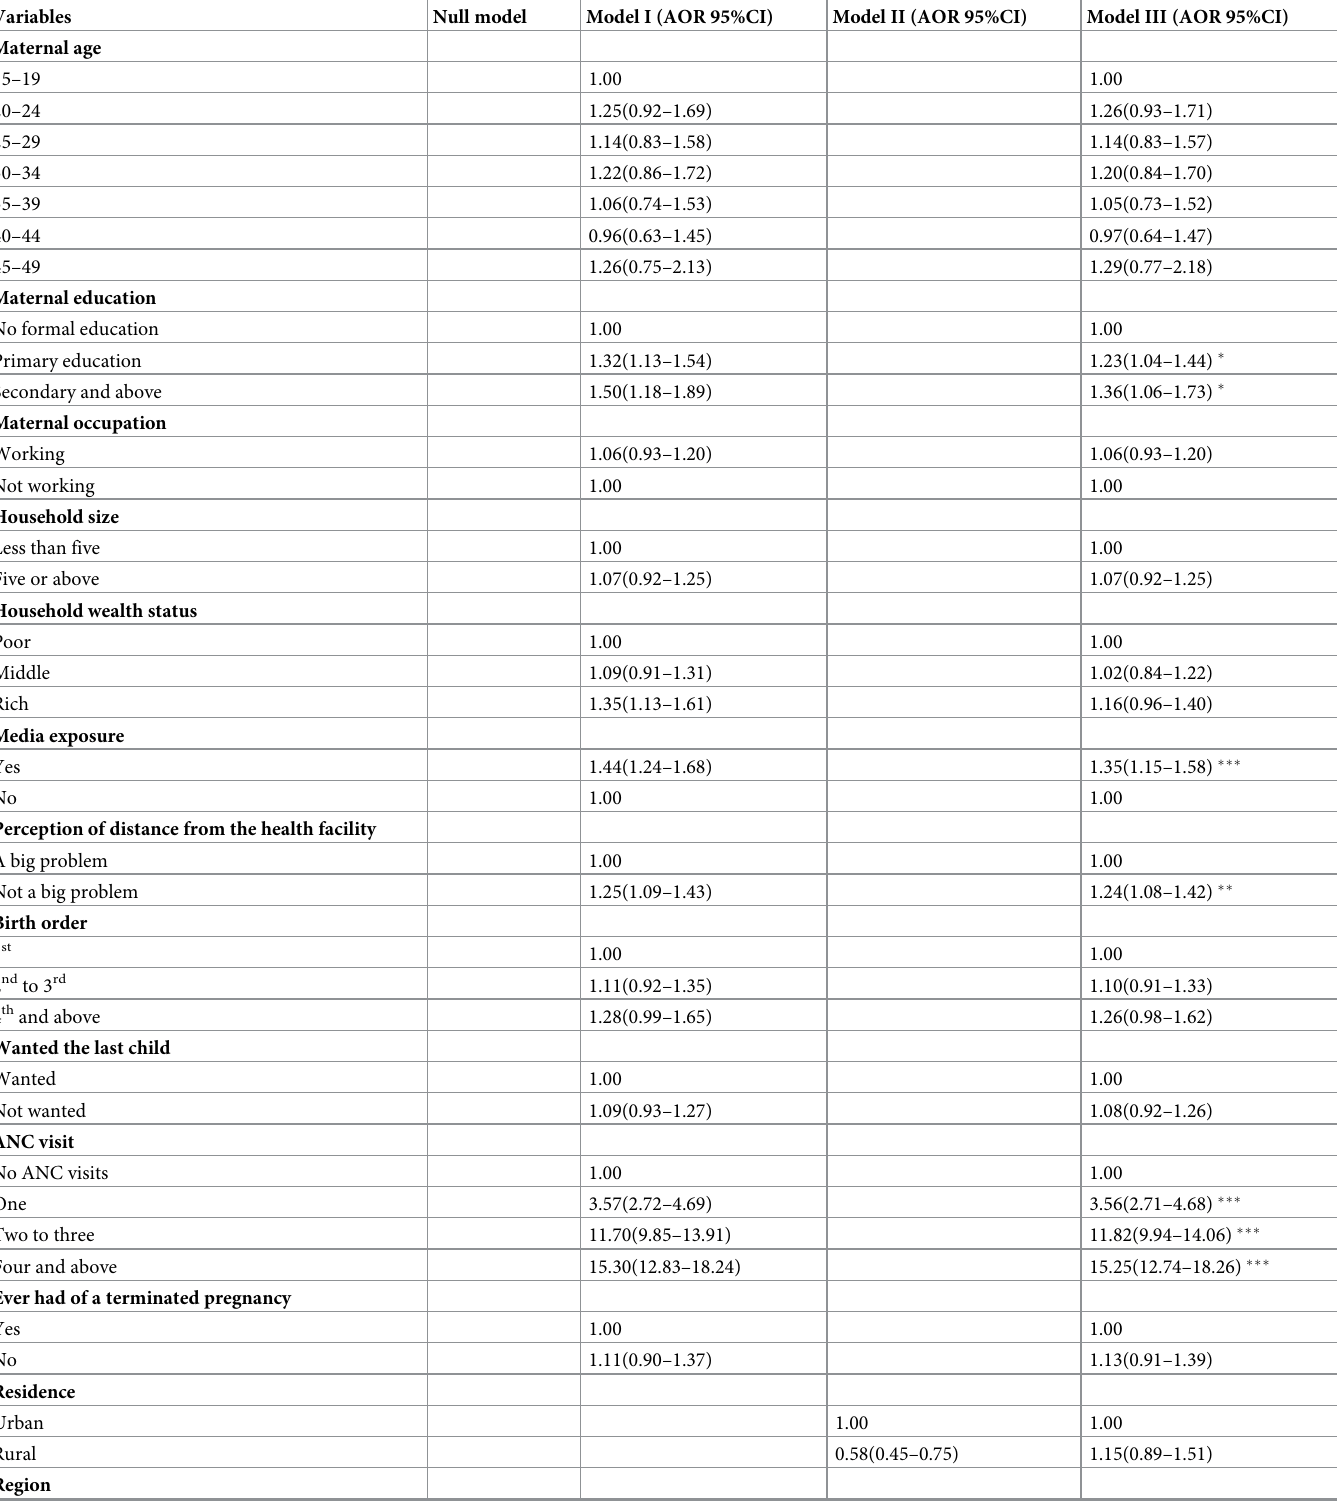
Table 3. Multivariable multilevel logistic regression analysis of determinants of births protected against neonatal tetanus in Ethiopia,